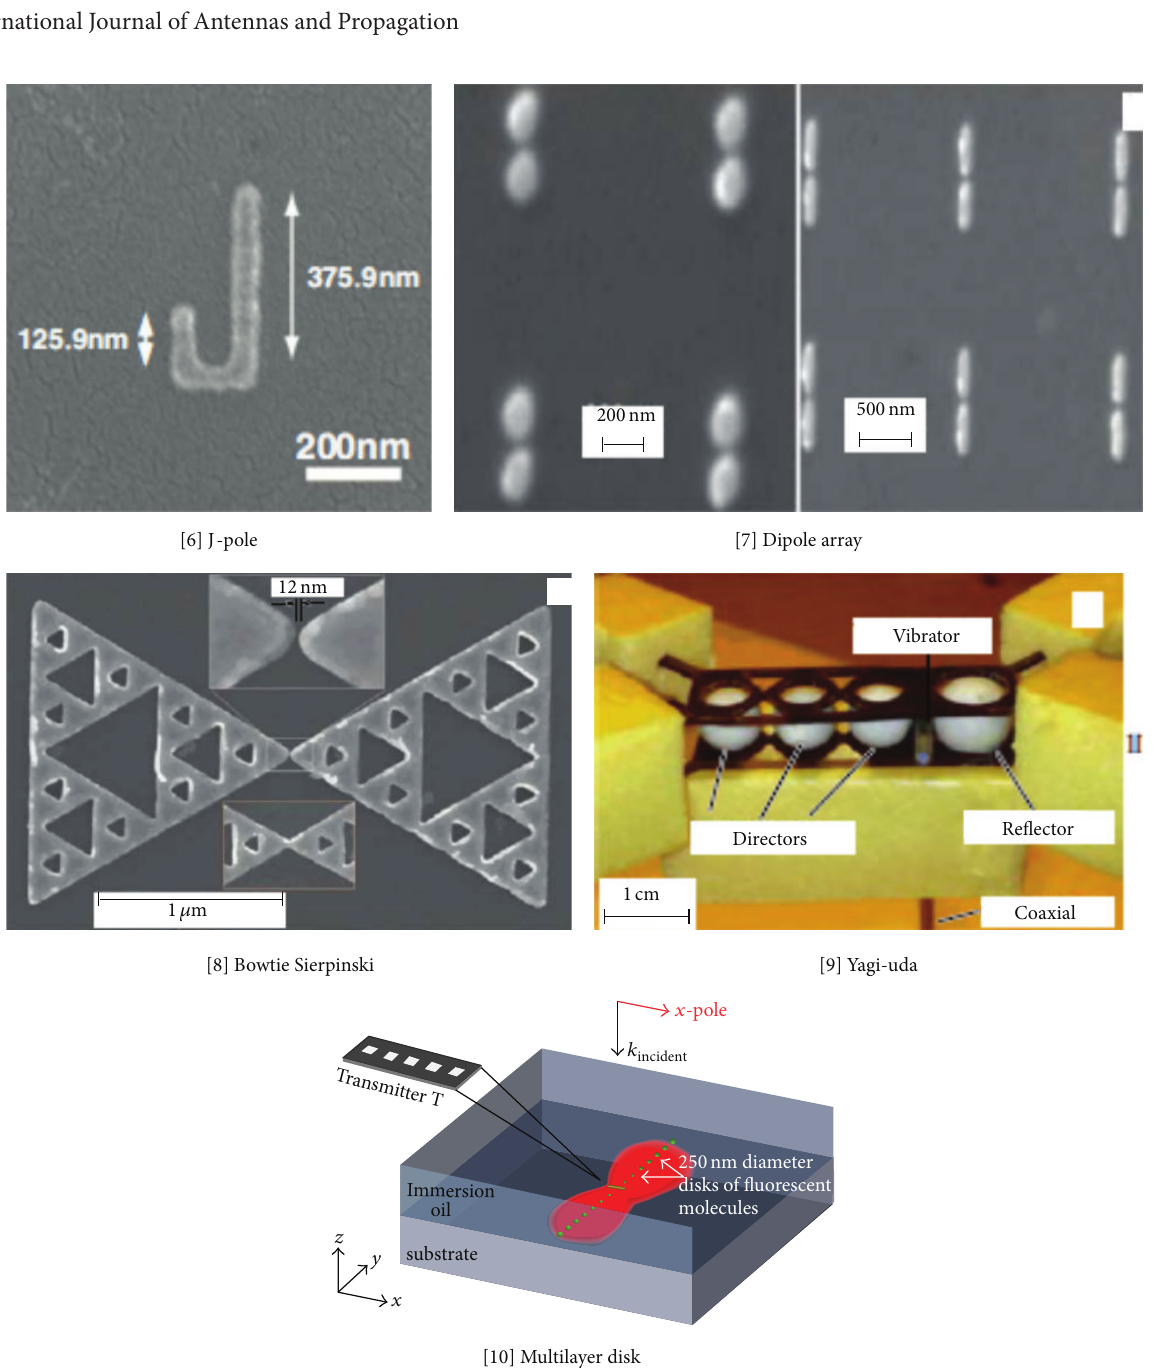
Figure 1: Various nanoantennas fabricated with different techniques. Source